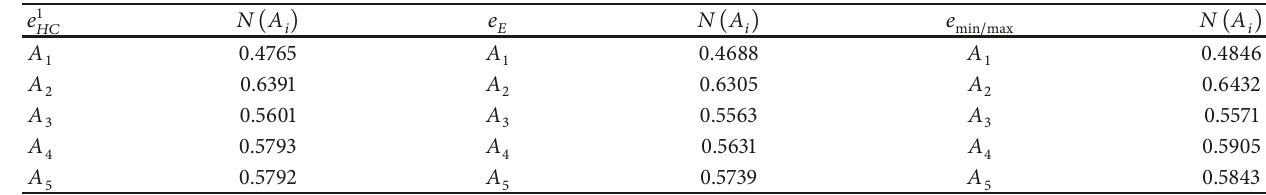
Table 15: Degree of relative closeness for each